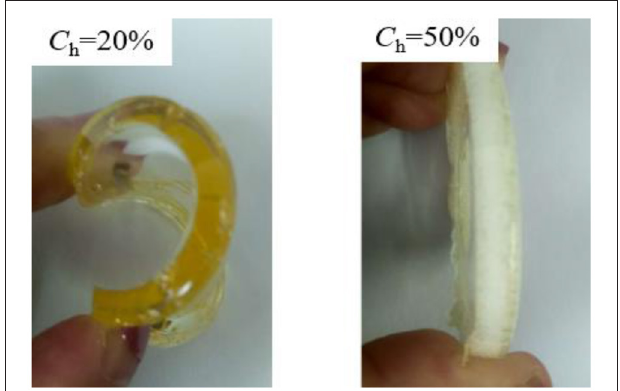
FIGURE 5 | TPU with different hard segment contents.